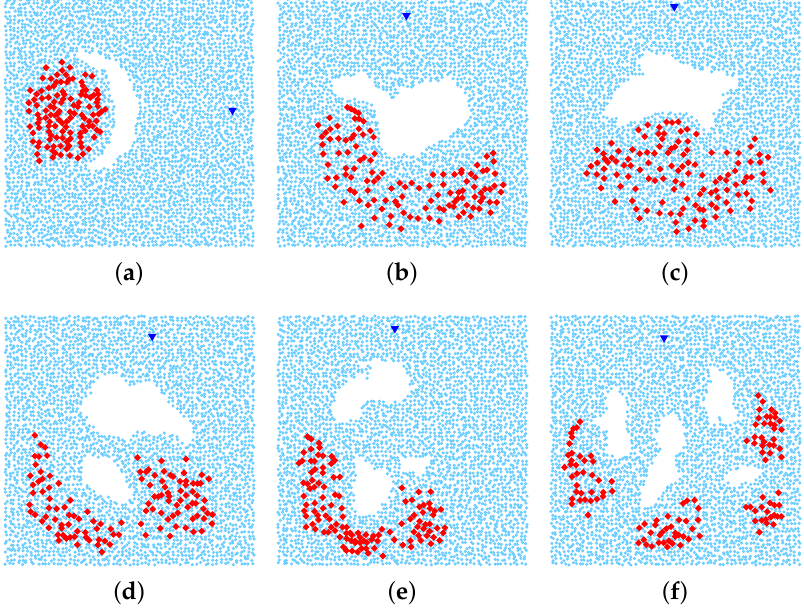
Figure 8. Network topologies for 1-n communication. ( a ) Topology 1. ( b ) Topology 2. ( c ) Topology 3. ( d ) Topology 4. ( e ) Topology 5. ( f ) Topology